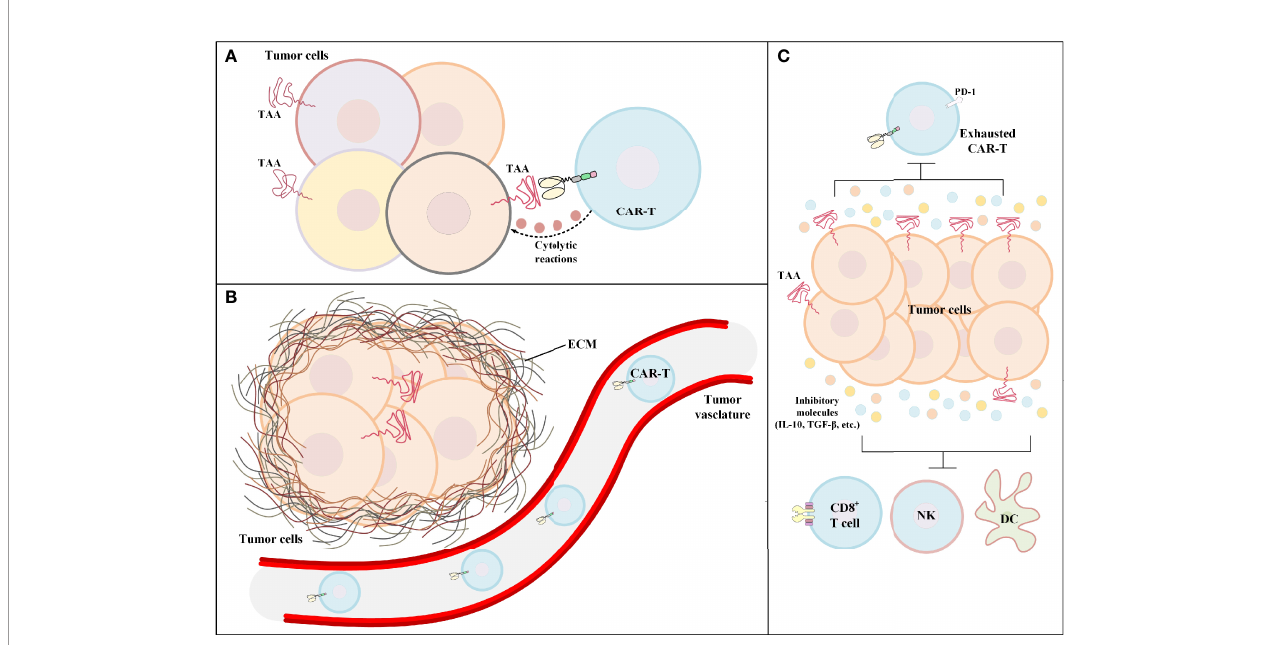
FIGURE 2 | The hurdles of CAR-T therapy in solid tumors. (A) Tumor antigen heterogeneity. In such conditions, the tumor bulk consists of tumor cells only a fraction of which express the CAR-redirected TAA on their surface. Other tumor cells may express different TAAs. (B) Poor tumor site CAR-T in fi ltration. In the case of hematologic malignancies, the adoptively transferred CAR-Ts encounter their target cells in the bloodstream or the lymphatic system. On the contrary, in solid tumor CAR-T therapy, CAR-Ts have limited accessibility to the tumor site rendering CAR-T-mediated tumoricidal reactions ineffective and insuf fi cient. (C) The immunosuppressive tumor microenvironment. The immunosuppressive characteristics of the tumor microenvironment have negative effects on both CAR-Ts and various immune cells responsible for endogenous antitumor responses. CAR-T, chimeric antigen receptor T cell; DC, dendritic cell; ECM, extracellular matrix; IL-10, interleukin-10; NK, natural killer cell; PD-1, programmed cell death receptor protein 1; TAA, tumor-associated antigen; TGF- b , transforming growth